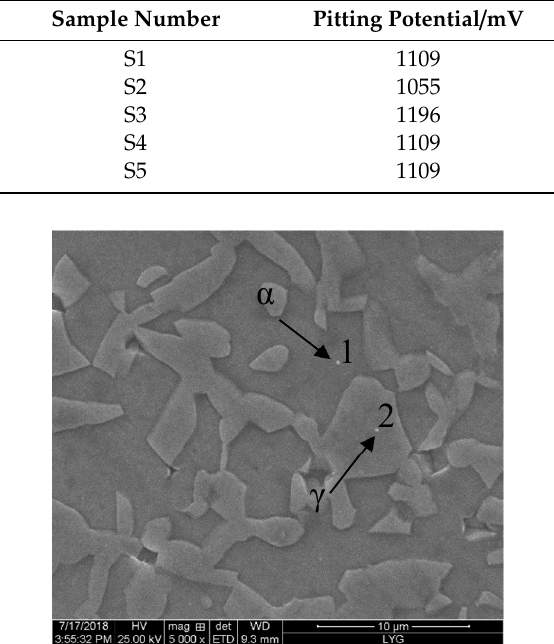
Figure 7. The EDS spectra of the S3 sample. Table 6. The element distribution of the α and γ phases (mass%).